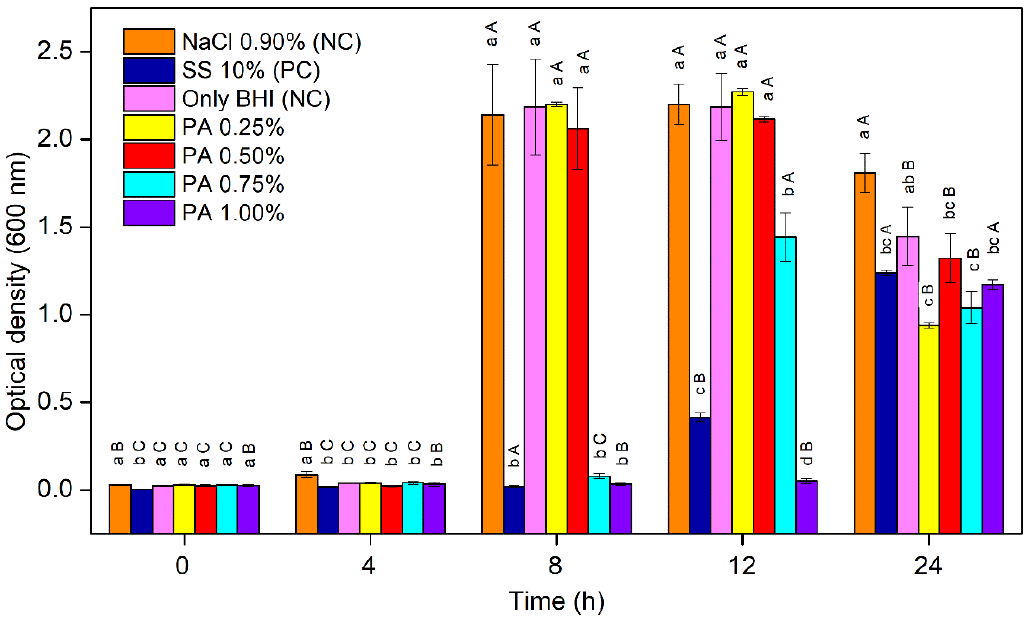
Figure 2. The effect of phytic acid (PA; 0%, 0.25%, 0.5%, 0.75%, and 1%), sodium sorbate (SS; 10%), and NaCl (0.9%) on the growth of C. perfringens vegetative cells; PC: positive control; NC: negative control. The error bars represent the standard error ( n = 3); different lowercase letters indicate statistically significant differences by Tukey’s test among samples at the same time ( p < 0.05); different uppercase letters indicate statistically significant differences by Tukey’s test among the same sample at different times ( p <